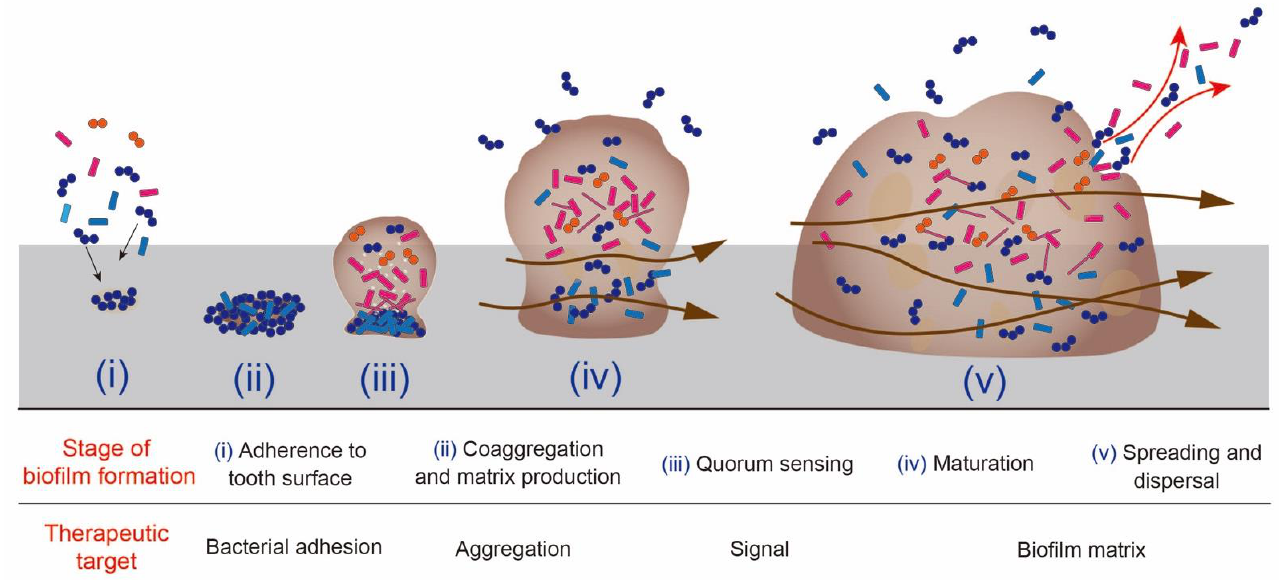
Figure 2. Biofilm formation and the therapeutic target for its control at each stage. The brown arrows indicate the channels that allow the transport of nutrients, waste products, and signaling molecules within the biofilm. The image is based on the process described by Costerton and Stewart in 2001 [38].